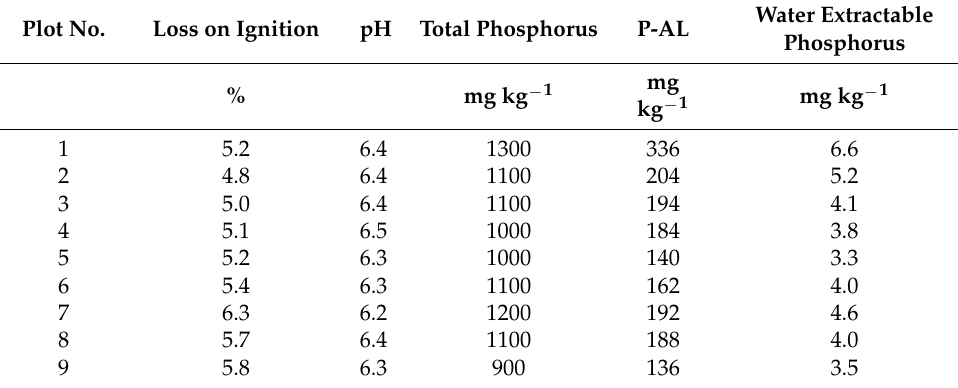
(P H2O ) from 3.3 to 6.6 mg kg − 1 (Table 1). The variations may reflect land management with application of more manure in the past on plot one compared to plot nine. Table 1. Loss on ignition (%), pH, total phosphorus (mg kg − 1 ) and Ammonium Lactate extractable phosphorus (mg P-AL kg − 1 ) in 0–20 cm depth for the nine plots. Water Extractable Plot No. Loss on Ignition pH Total Phosphorus P-AL Phosphorus %